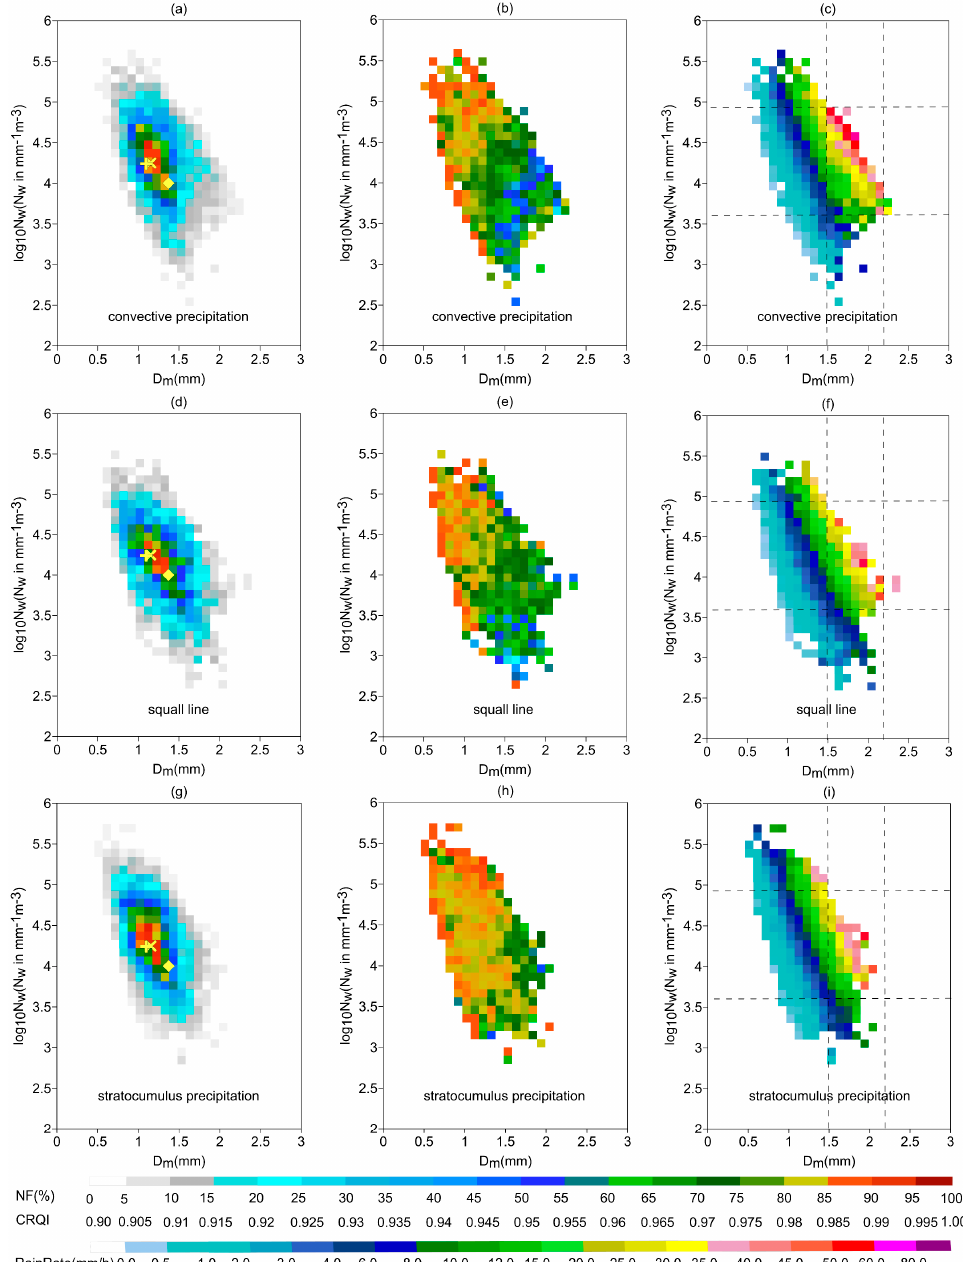
Figure 8. ( a , d , g ) Normalized occurrence frequency (NF) of log 10 N w versus D m . ( b , e , h ) CRQI of log 10 N w versus D m . ( c , f , i ) Hourly accumulated precipitation observed by RG stations of log 10 N w versus D m . The top, middle, and bottom rows show the parameters for convective precipitation, squall line, and stratocumulus precipitation, respectively. D m and N w were derived from good-quality Z H and Z DR for all rainfall events. The dashed lines mark the area with heavy rain due to convective precipitation.